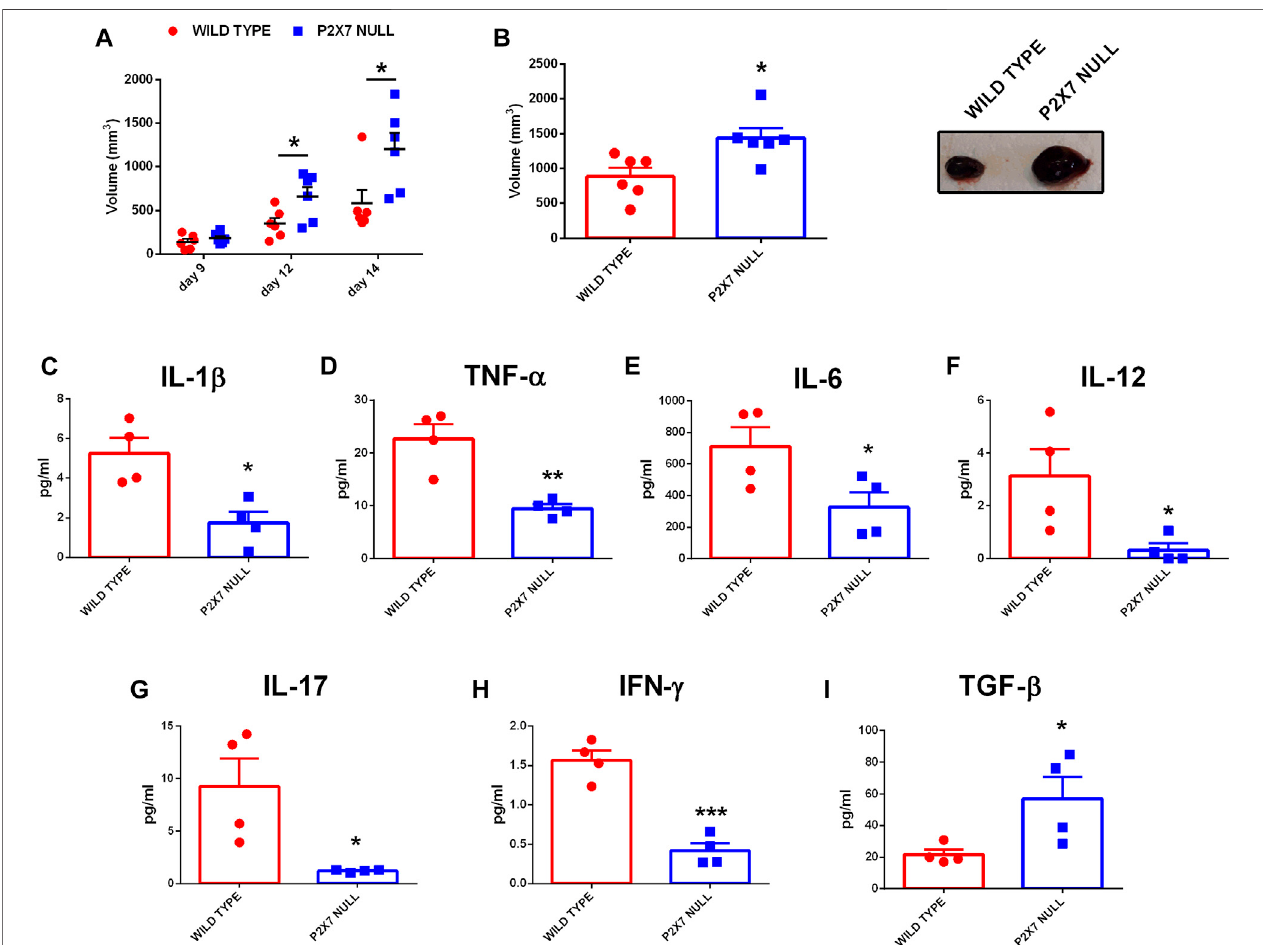
FIGURE 1 | C57bl/6 mice were inoculated into the right fl ank with B16-F10 cells in wild type and P2X7-null mice. (A) Tumor volume was in vivo assessed at the indicated time points. (B) Ex-vivo tumor volume assessed by calliper. (C) Representative pictures of tumors from wild type and P2X7 null mice at post-inoculum day 14 ( n = 6per group). (D – J) Levels ofplasma cytokines oftumor-bearing C57bl/6 mice inoculated with B16 cells. IL-1 β (D) , TNF- α (E) , IL-6 (F) , IL-12 (G) , IL-17 (H) , IFN- γ (I) andTGF- β (J) wereevaluatedinplasmasamplesobtainedatpost-inoculumday14( n =4pergroup).Dataareshownasthemean±SEM.* p < 0.05,** p < 0.01and *** p <